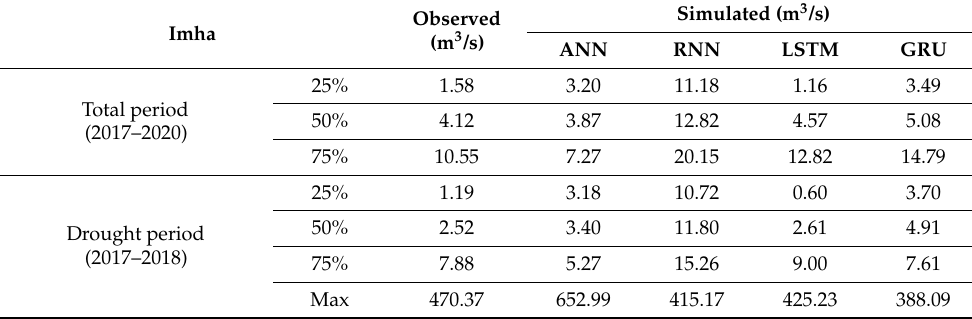
Table 9. Typhoon cases.